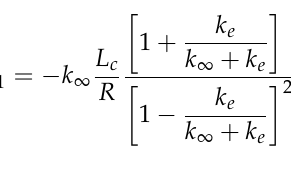
Figure 6. Stability analysis for | k e | ∈ [ 0; k ∞ external damping, yielding the stable spin speed ranges; and ( b ) the corresponding root